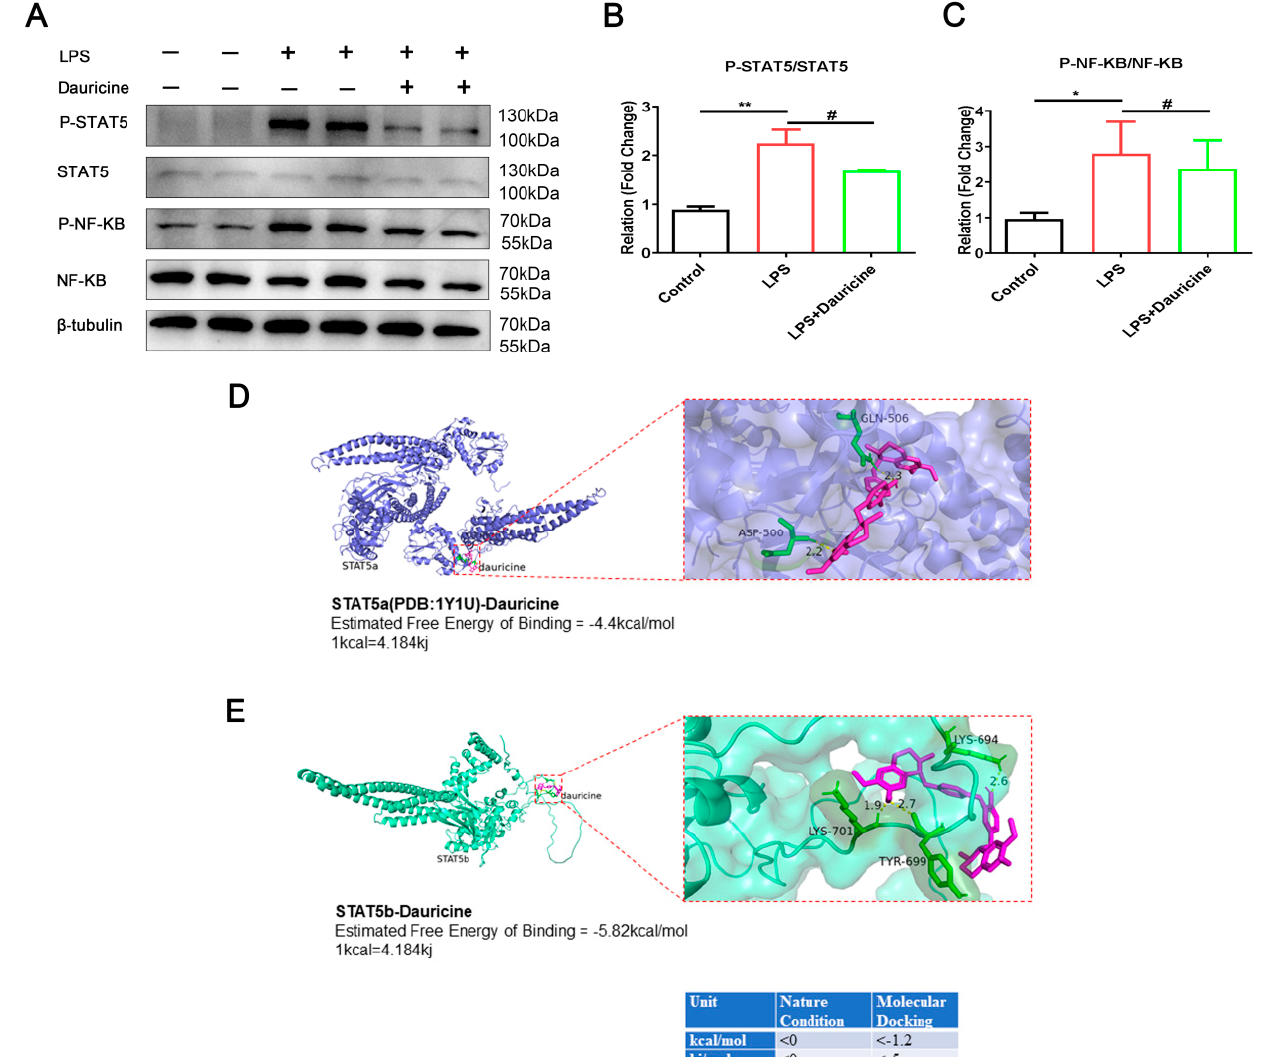
Figure 6. Dauricine inhibited the activation of STAT5, NF- κ B and docked with STAT5. ( A ) The western blot representative figure of NF- κ B, P-NF- κ B, STAT5, P-STAT5 and β -tubulin were showed and was counted with ratio of P-STAT5 to STAT5 ( B ) and P-NF- κ B to NF- κ B ( C ). n = 3, Control group vs. LPS group, * p < 0.05, ** p < 0.01; LPS group vs. (LPS + Dauricine) group, # p < 0.05, unpaired Student’s t- test. Ligand receptor docking was performed with AutoDock and analyzed with PyMOL. The top panel shows the joint diagram of dauricine and STAT5a protein ( D ), and the lower panel shows the joint diagram of dauricine and STAT5b protein ( E ), the energy data under natural conditions and molecular docking is noted at bottom right.